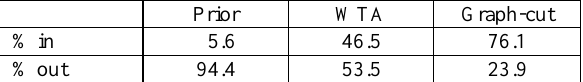
Table 1. Percentage of disparity inliers and outliers at control points.